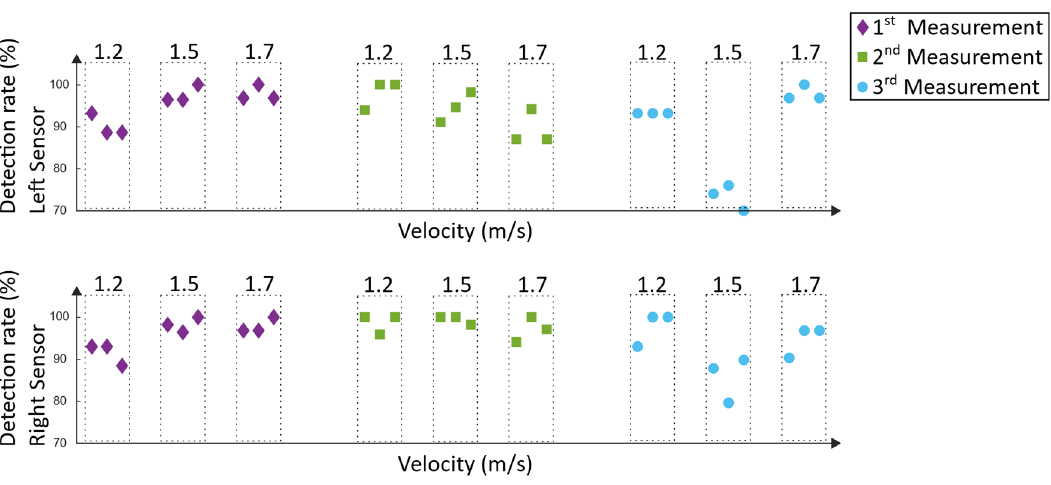
Figure 24. Detection rate of the Lyra measurements.